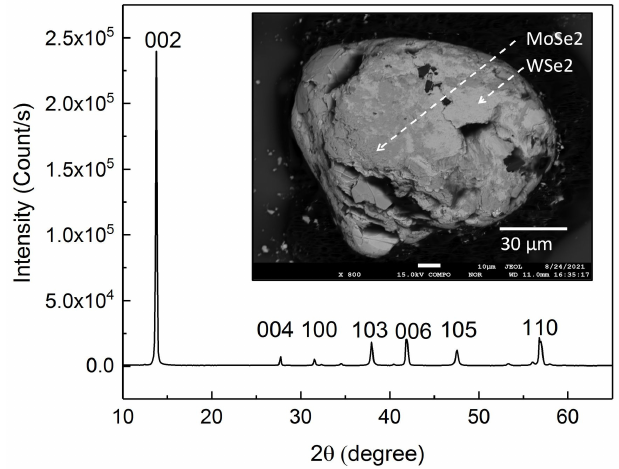
Figure 1. The XRD spectrum of the WSe 2 /MoSe 2 powder. The peak position is consistent with the database. The sharp peaks imply that the sample is highly crystallized. The top-right inset shows that SEM image in the backscattering emission image mode. The light area is the WSe 2 , and the dark area is the MoSe 2 . The phases of WSe 2 and MoSe 2 are separated.